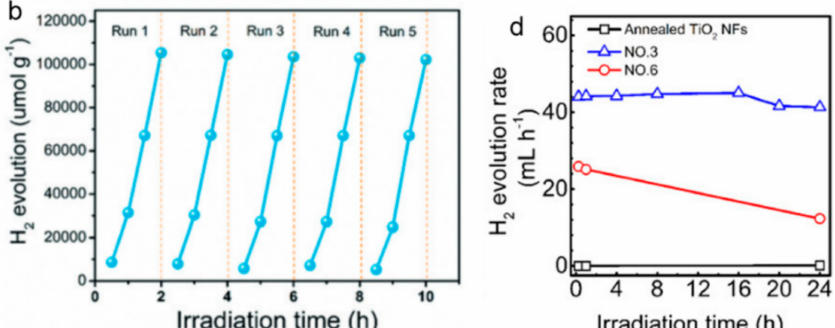
Figure 11. ( a , b ) The TOFs photocatalytic H 2 production activities and cyclic tests under UV/Vis light illumination of Pt-SA/Def-TiO 2 and Pt-NP/TiO 2 . Inset in ( a ) is the TEM image of Pt-SA/Def- TiO 2 . The scale bar is 2 nm. Adapted with permission from Ref. [153] ( c ) Amount of H 2 evolution photogenerated over 24 h of irradiation at λ = 365 nm for the annealed, the “dark”-deposited (NO. 3), and the pre-photodeposited (NO. 6) TiO 2 NFs. ( d ) Photocatalytic H 2 evolution rate over 24 h illumination for the samples shown in ( c ). Adapted with permission from Ref.